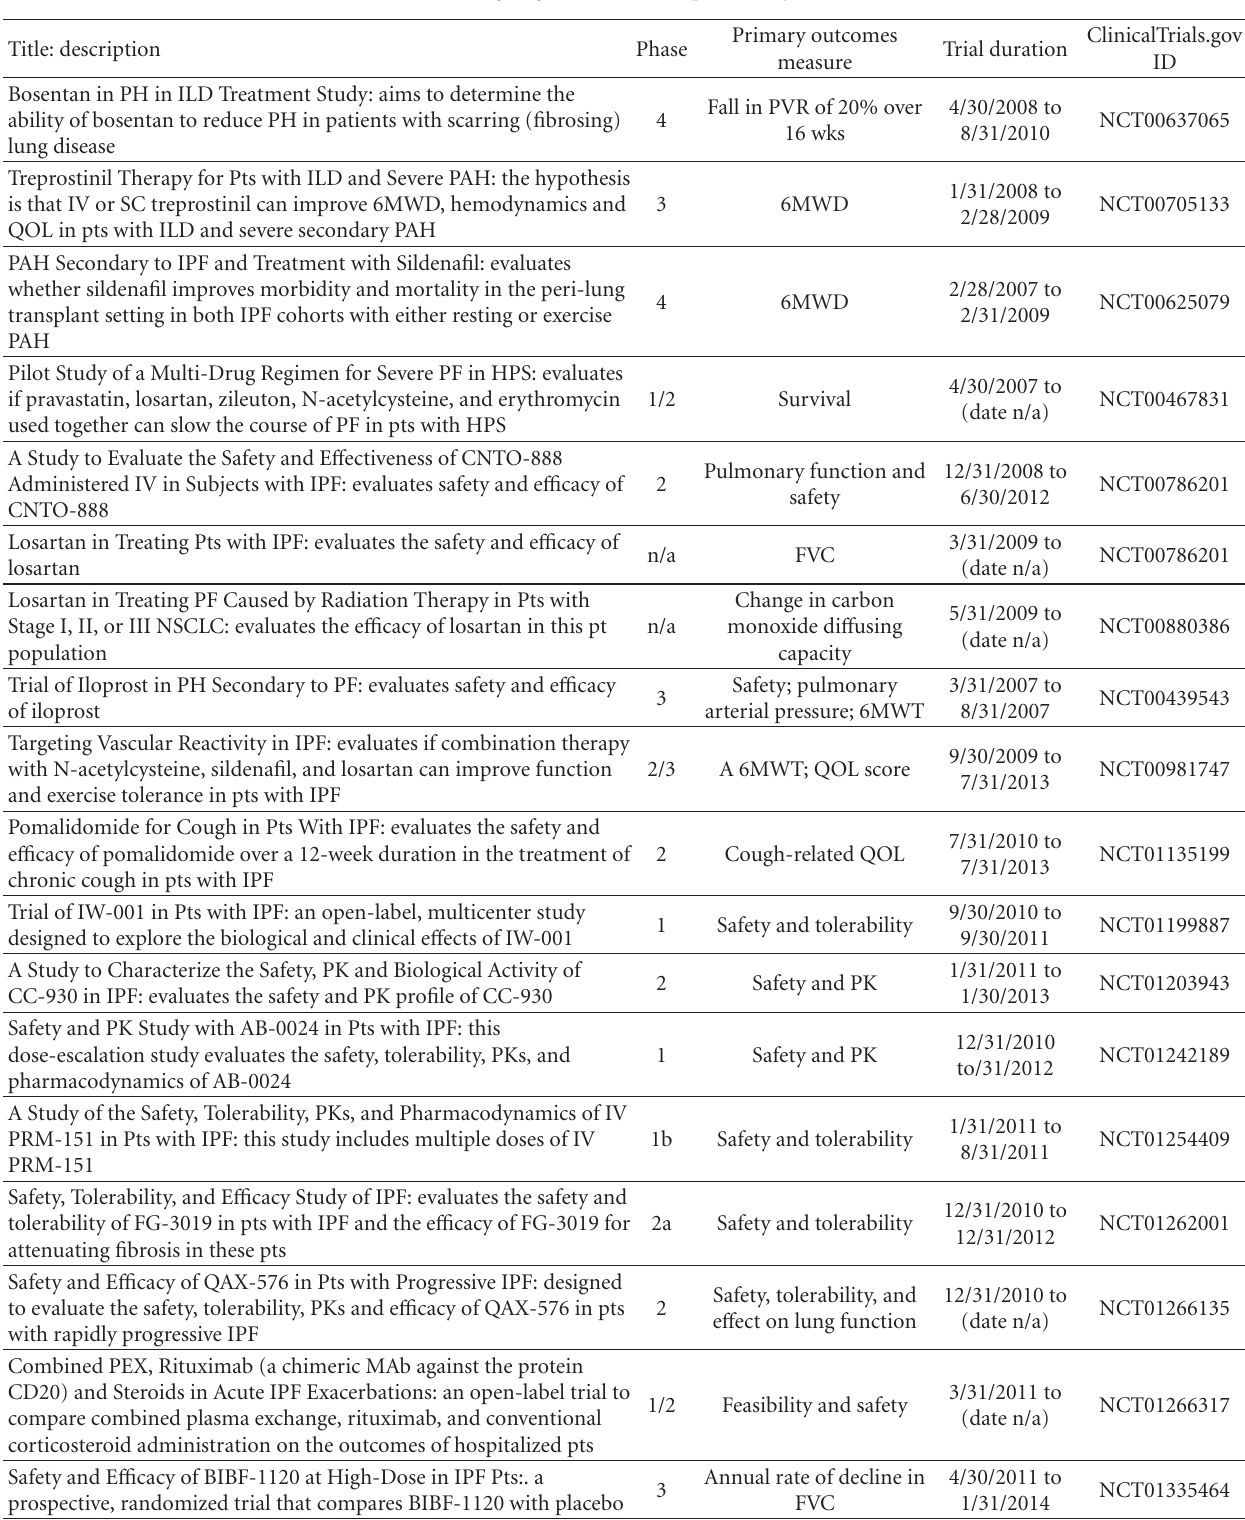
Table 2: Ongoing clinical trials in pulmonary